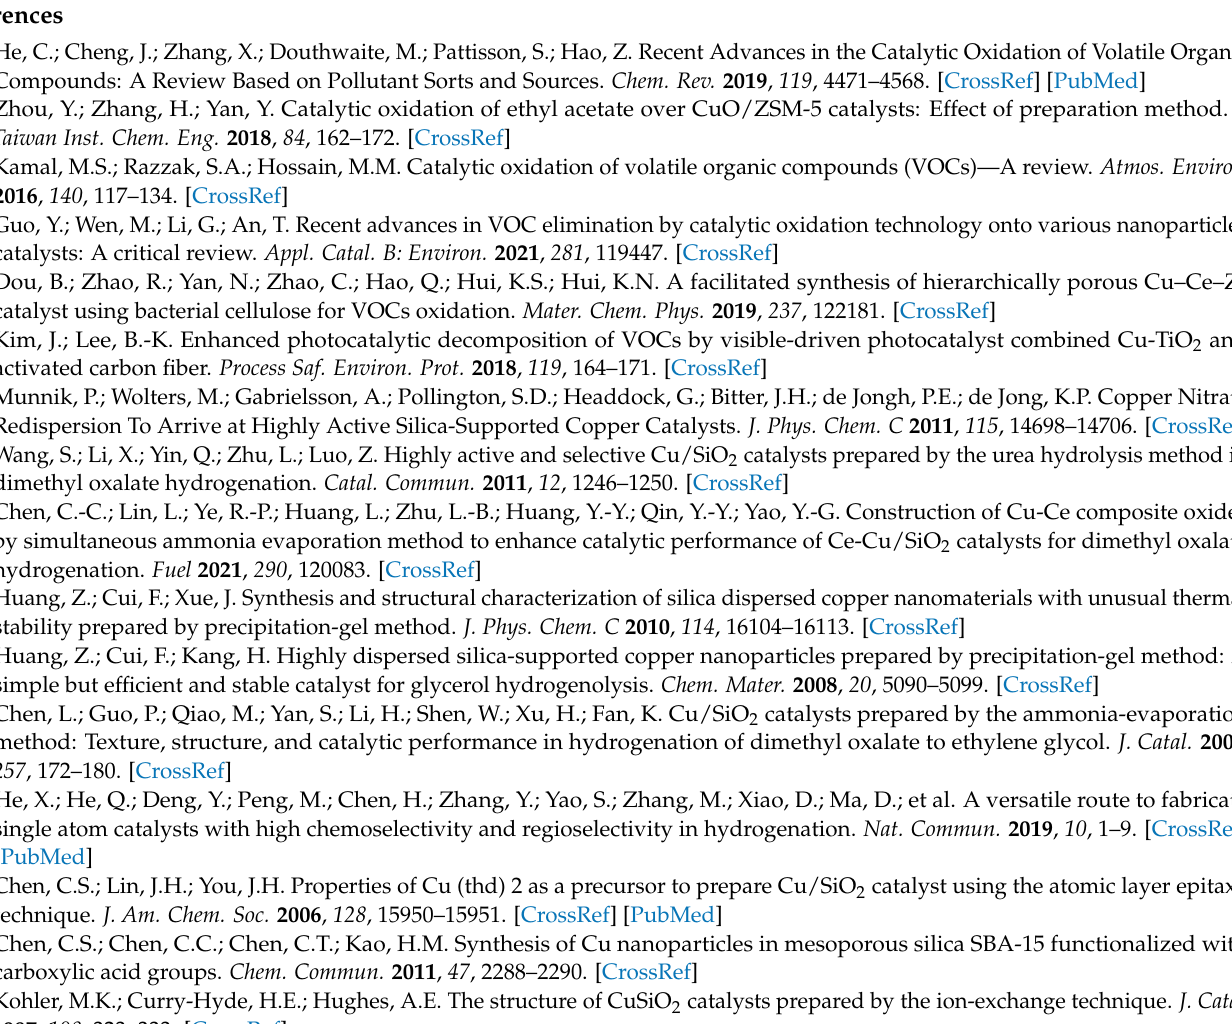
Figure S3. N2 adsorption isotherms curves (A) and pore size distribution (B); Figure S4: XRD comparison of copper acetate standard before and after BM; Figure S5: FT-IR spectra of the calcined samples of 30%Cu-A-BM and 20%Cu-A-BM (The two samples were calcined at 500 ◦ C); Figure S6: XPS surveys of all catalysts; Figure S7. Cu2p spectra of 20%Cu-A-BM (uncalcined); Figure S8: (a,b) Selectivities of CO 2 over the CuO/SiO 2 catalysts; Figure S9: Stability of the 15%Cu-A-BM catalyst at 270 ◦ C; Figure S10: XRD patterns of the spent and the fresh 15%Cu-A-BM